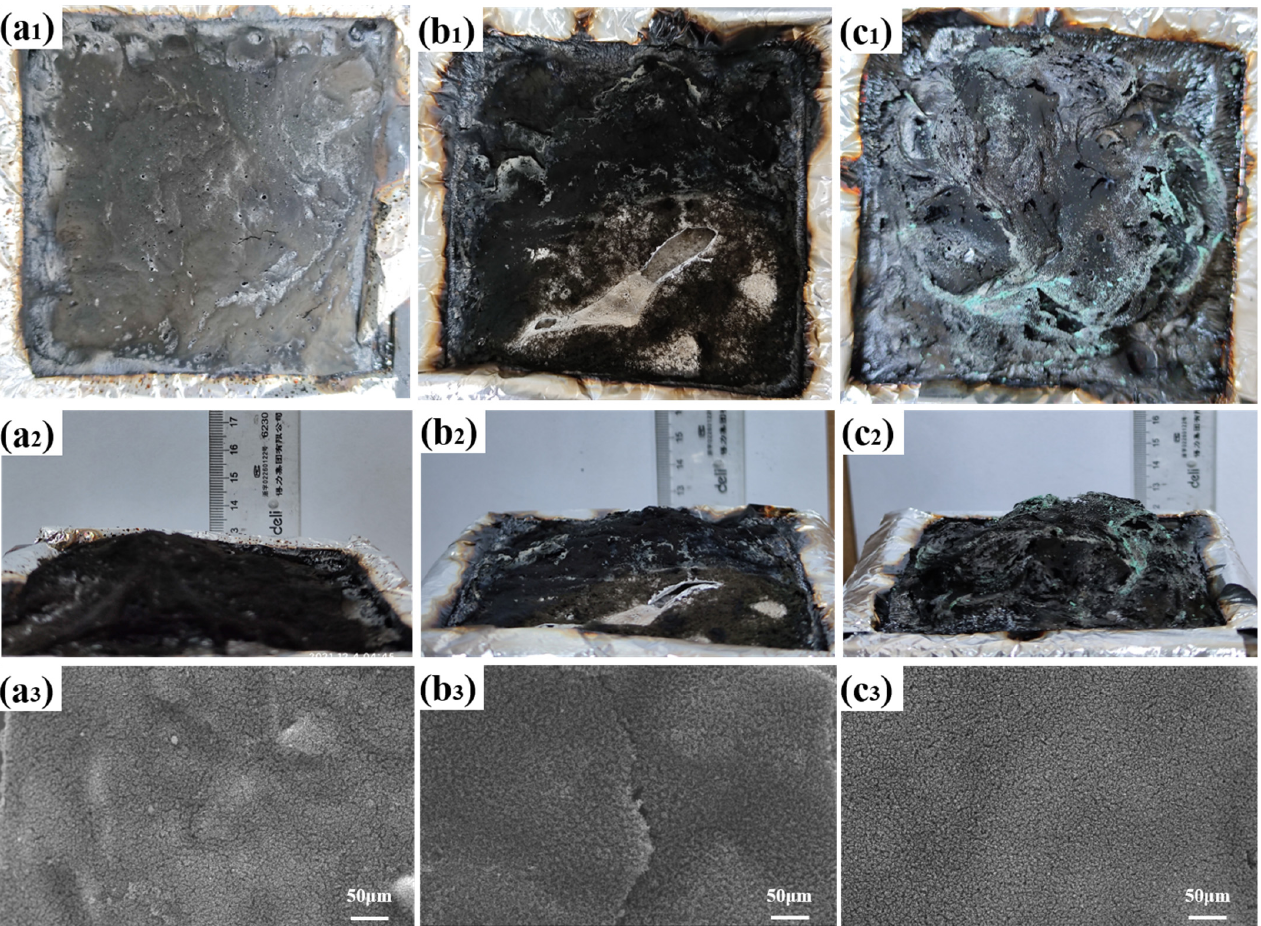
Figure 8. Digital and SEM images of the residues for ( a 1 – a 3 ) TPU, ( b 1 – b 3 ) TPU/ZIF-67, and ( c 1 – c 3 ) TPU/ZIF-67@MXene composites.